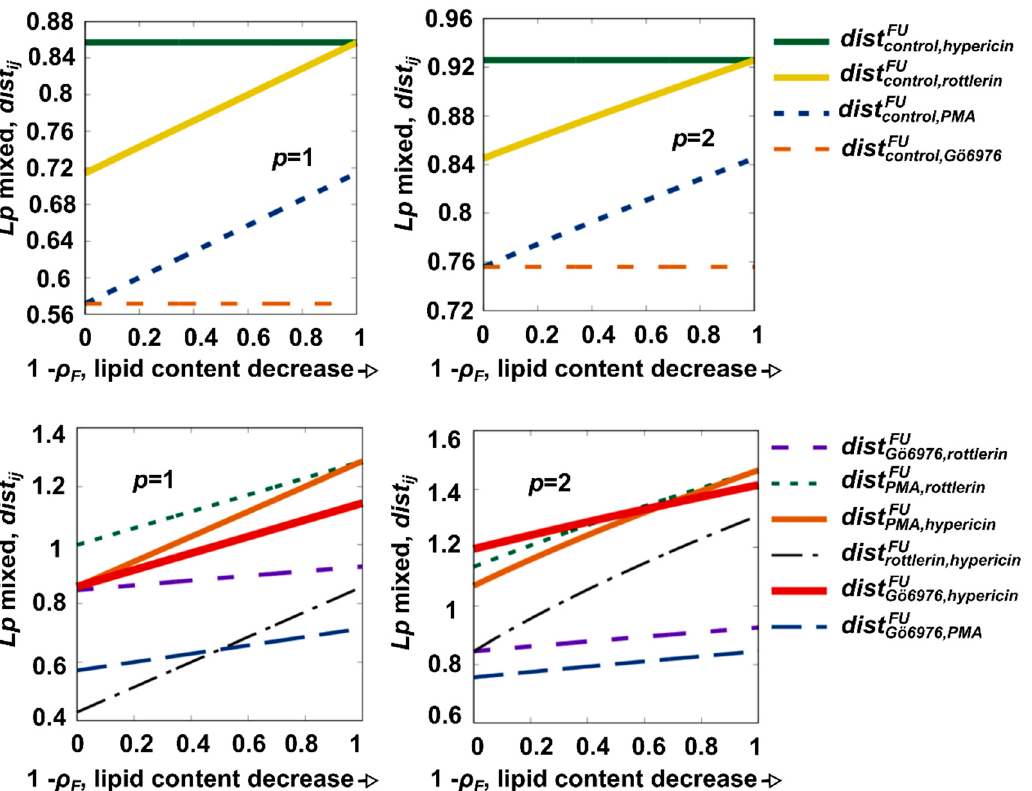
Figure 3. Distances between pairs of measured data patterns. The parameter p is a free parameter that can be used to deliberately change the distance definition. The values p = 1 and p = 2 are considered as exceptions. ρ F is the homotopy parameter that controls the normalized lipid content.